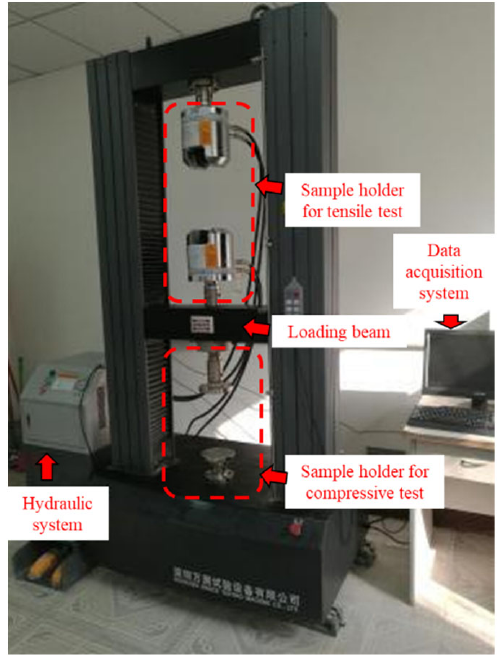
Figure 4. ETM105D universal material testing system.